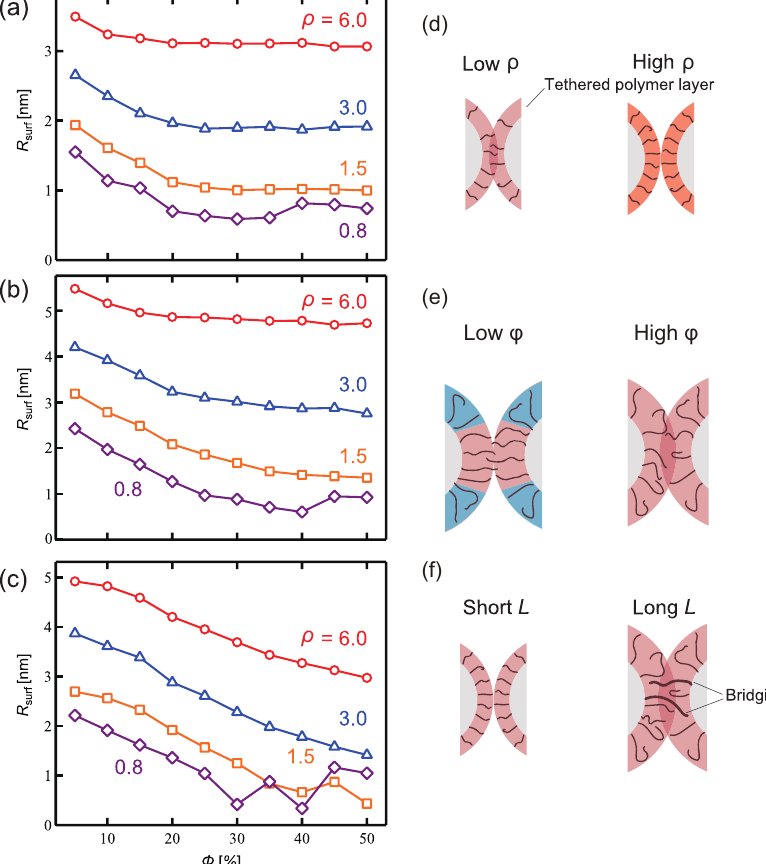
Figure 3. Distance between PTNP surfaces ( R surf ) with respect to the coverage ratio φ and tethered polymer length L : ( a ) L = 3, ( b ) L = 6, and ( c ) L = 9. Schematics illustrating the differences in R surf according to ( d ) ρ , ( e ) φ of a hydrophobic tether, and ( f ) L